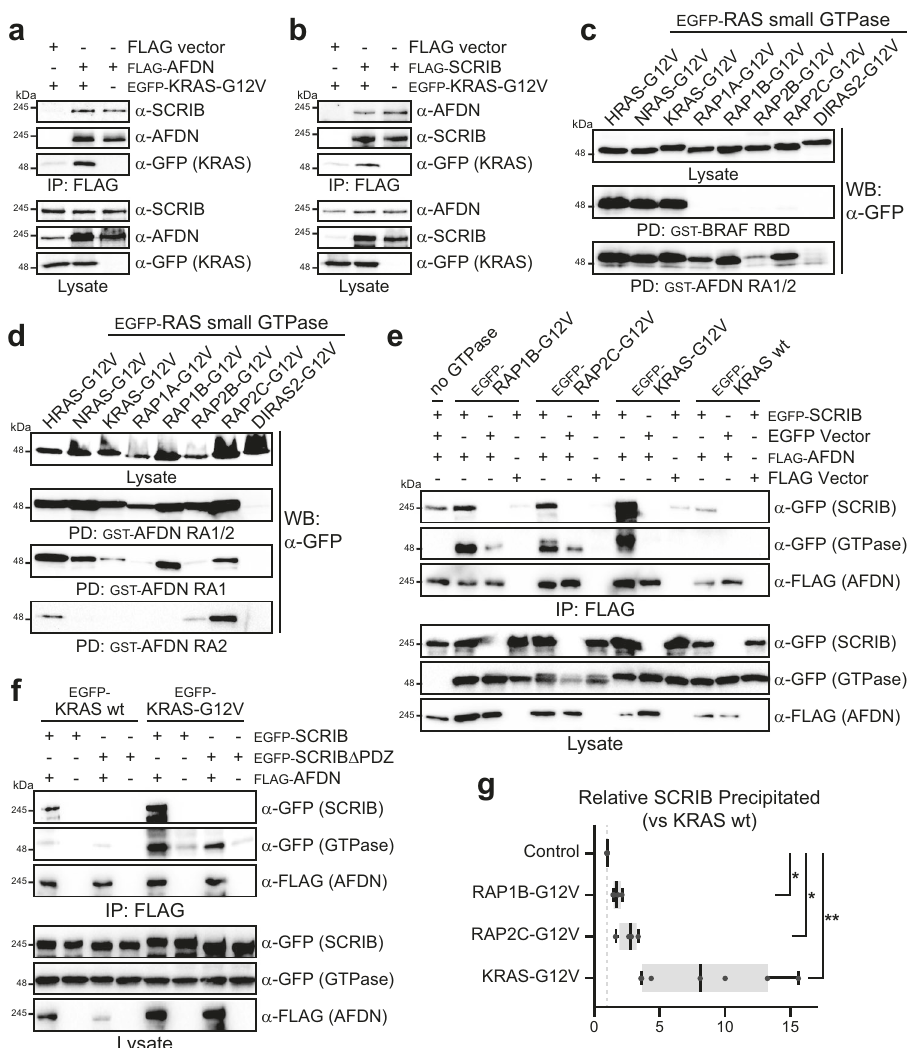
Fig. 4 | RAS GTPases complex with AFDN-SCRIB. a Activated KRAS is co- precipitatedwithAFDNandSCRIB.HEK293Tcellswereco-transfectedwithvectors expressing FLAG-AFDN and EGFP-KRAS-G12V (constitutively active). Both endo- genous SCRIB and KRAS-G12V were detected following anti-FLAG IP. FLAG vector alone was a control. b Activated KRAS and AFDN co-IP with SCRIB. HEK 293T cells were co-transfected with vectors expressing FLAG-SCRIB and EGFP-KRAS-G12V. Endogenous AFDN and KRAS-G12V were detected following anti-FLAG IP. c The RA1/2 domains of AFDN interact with multiple RAS small GTPases. EGFP-tagged GTPases with activating mutations were expressed in HEK 293T cells, and GST- tagged RBDdomains from BRAFor AFDNpuri fi ed from bacteria.GST-RBDs bound toglutathionebeadswereusedtopulldown(PD)GTPases,aWesternblotwithanti- GFPrevealed interacting proteins. d Speci fi city ofindividualAFDN RAdomainsfor RAS GTPases. GST-tagged RA1, RA2 or RA1/2 were puri fi ed and mixed with lysates expressingtheindicatedGTPases.Ananti-GFPimmunoblotfollowingprecipitation on glutathione beads revealed bound GTPases. Each blot was exposed for 30sec- onds. e Activated GTPases co-precipitate with AFDN and augment interaction with